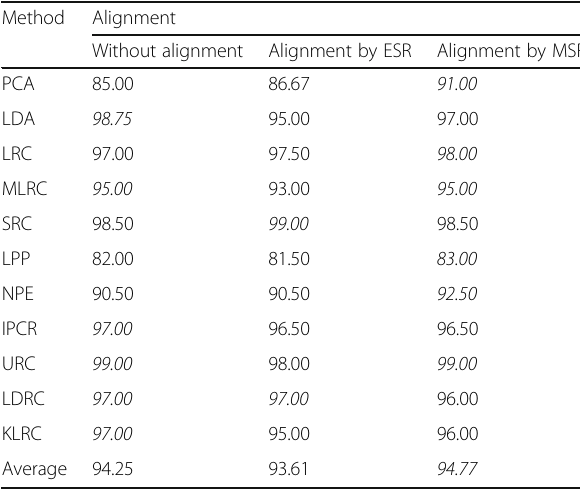
Table 6 Recognition performances (%) on AR database (normal faces) Method